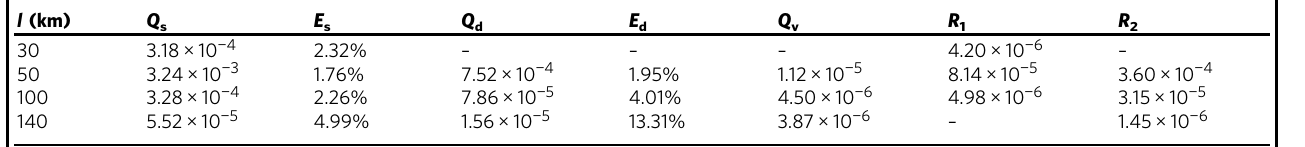
List of mean yields and errorrates of signal ( Q s and E s ),decoy ( Q d and E d ),and mean yield of “ vacuum ” ( Q v )packets, secretkeyrates perpulse ( R 1 and R 2 ) forfour lengths of the fi berchannel( l ),where R 1 is calculated without usingthe error rate while R 2 is calculated with using the error rate. At 30km, the decoy states method is not employed, so Q s and E s represent the yield per packet and error rate of all key bits,